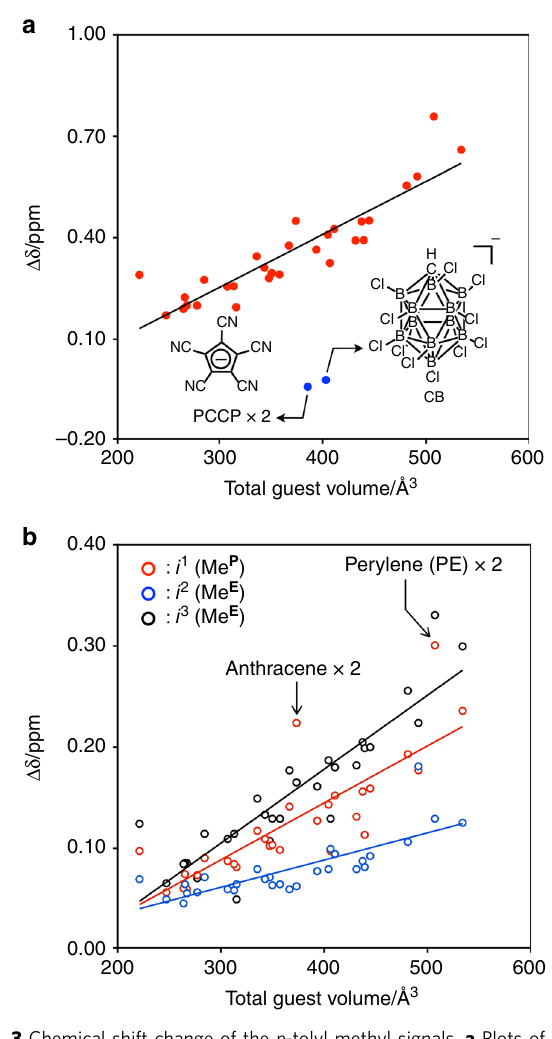
Fig. 3 Chemical shift change of the p -tolyl methyl signals. a Plots of total chemical shift changes of the p -tolyl methyl signals (the sum of chemical shift changes of the three p -tolyl methyl signals) upon the encapsulation of guest molecules. Red and blue solid circles indicate neutral and anionic guests, respectively. b Plots of chemical shift change of each p -tolyl methyl signal ( i 1 , i 2 , and i 3 ) upon the encapsulation of neutral guest molecules. The guest molecules tested are summarized in Supplementary Table